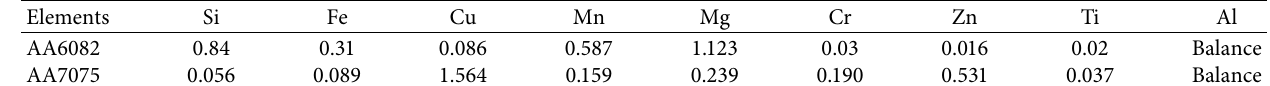
Table 3: Chemical composition of AA6082 and AA7075 Al alloys in wt%.